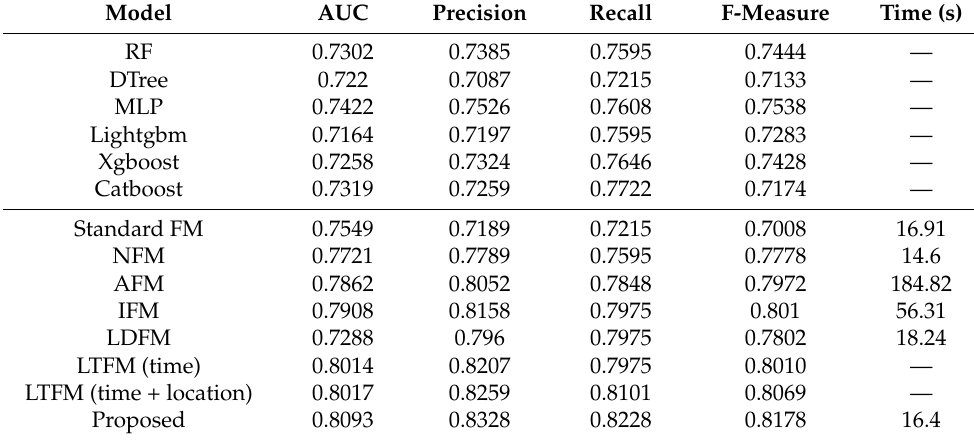
Table 5. Model performance